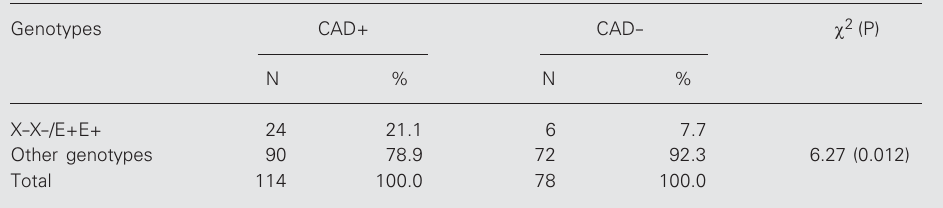
Table 4. Frequency distributions of two apo B genotype classes ( Xba I/ Eco RI) compared by the (cid:1) 2 test in the CAD+ and CAD- groups.